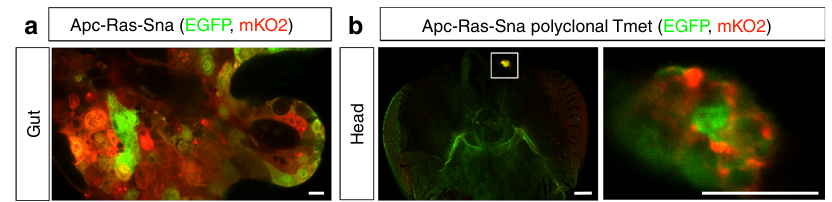
Fig. 5 Snail induces polyclonal metastases. Apc-Ras-Sna tumors labeled with the dBrainbow reporter. Enhanced green fl uorescent protein (green) and mKO2 (red) were imaged in fi xed stained midguts ( a ) or un fi xed tissues ( b ). Both midgut tumors ( a ) and metastases ( b ) were polyclonal. Scale bars: ( a , b left) 50 µ m; ( b right) 20 µ m